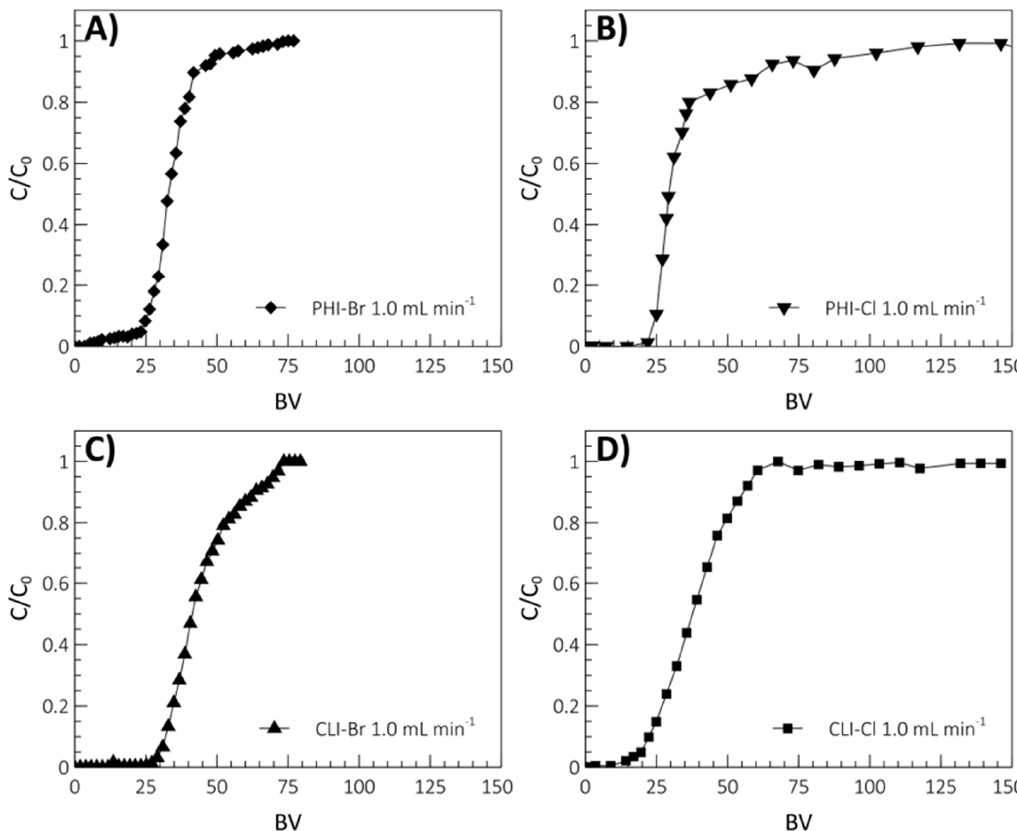
Figure 8. As breakthrough curves for PHI-Br ( A ), PHI-Cl ( B ), CLI-Br ( C ) and CLI-Cl ( D ) samples.